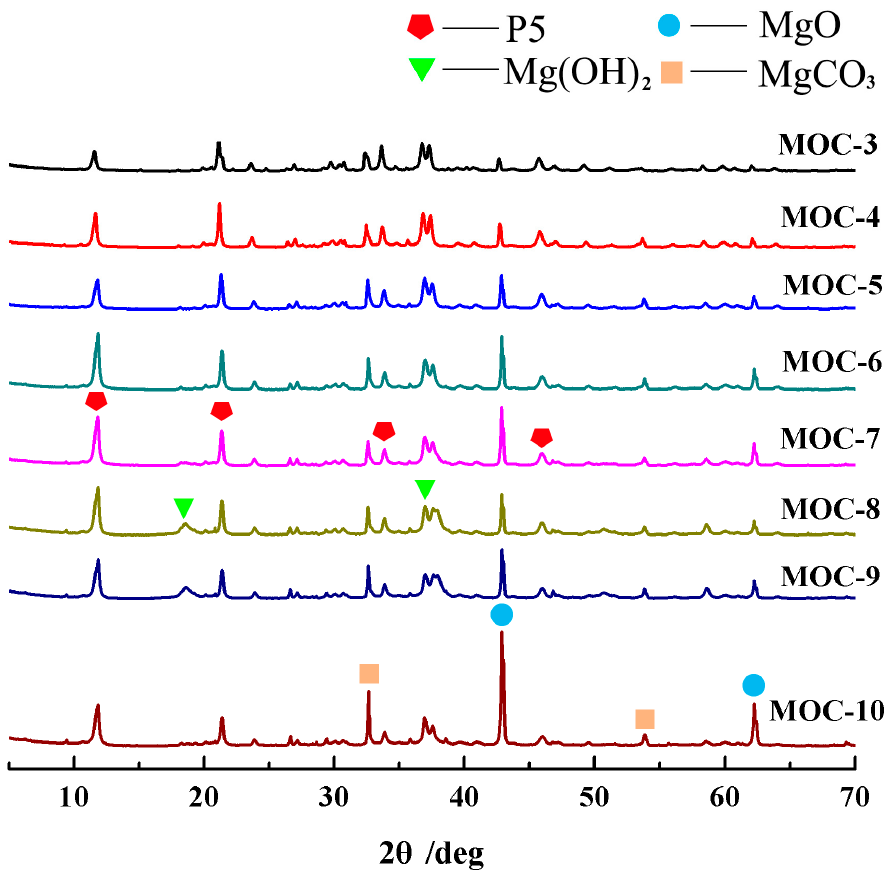
Figure 2. XRD patterns of MOC adhesives.